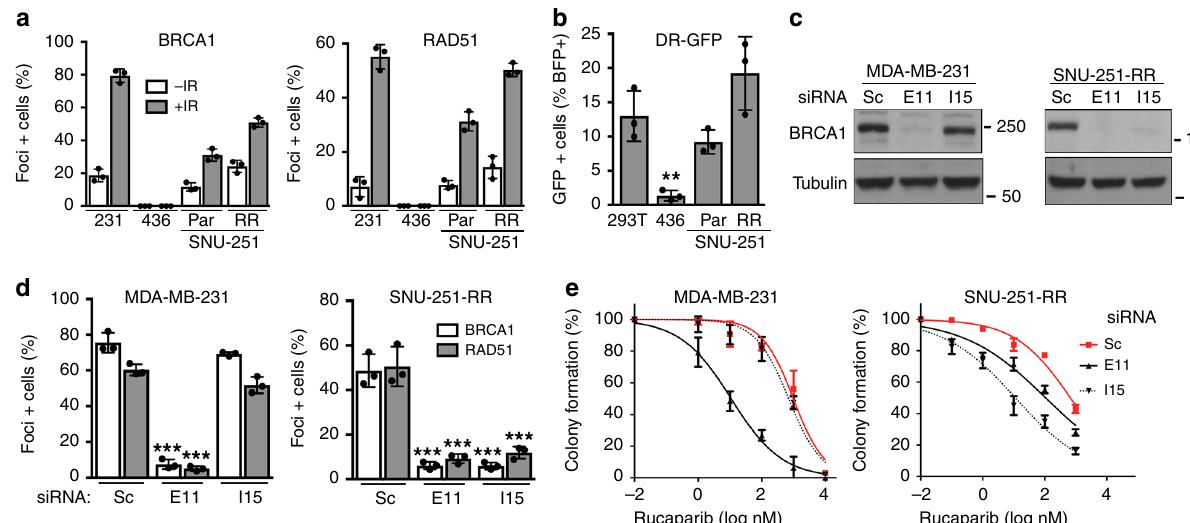
Fig. 4 BRCA1-I15 promotes PARPi resistance. a BRCA1 and RAD51 foci formation was assessed by immuno fl uorescence (IF) with or without 10 Gy IR. See Supplementary Fig. 3b for representative images as well as γ -H2AX and 53BP1 controls. b HR repair capacity assessed by DR-GFP assay. ** p < 0.01 compared to 293T cells. See Supplementary Fig. 3c − d for representative histograms and summary. c MDA-MB-231 and SNU-251-RR cells were treated with scrambled (Sc), BRCA1 exon 11 (E11) or intron 15 (I15)-targeting siRNA and BRCA1 protein expression assessed by Western blotting. d Cells were treated as in panel ( c ) and examined by IF for BRCA1 and RAD51 foci post 10 Gy IR. *** p < 0.001 compared to Sc-treated cells. See Supplementary Fig. 3e for representative images. e Cells were treated as in panel ( c ) and subject to increasing concentrations of rucaparib and colony formation assessed. Data are the mean ± SD of n = 3 biological replicates. Statistical signi fi cance was assessed by unpaired, two-tailed t